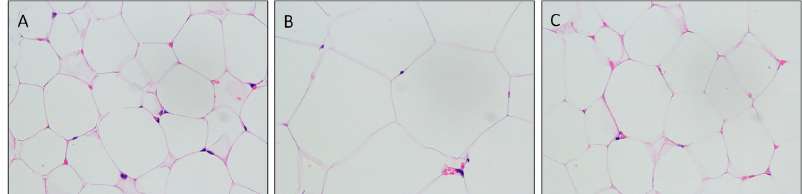
Figure 2. Hematoxylin-eosin (HE) staining slice of adipose tissue (400×). ( A) , normal control (NC); ( B) , model control (MC); ( C) , positive control (PC).